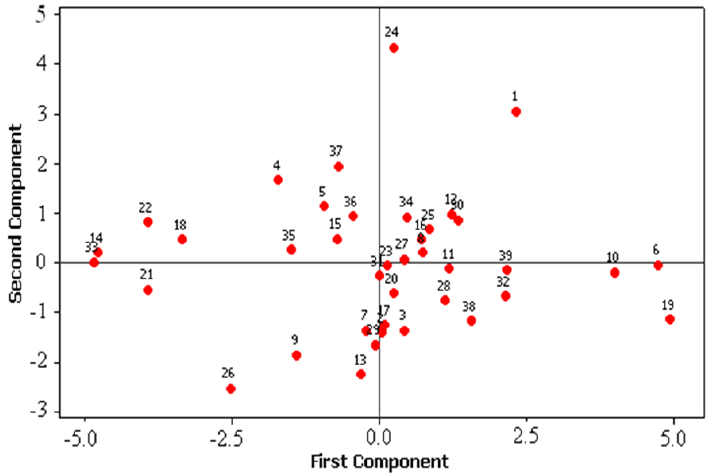
Fig. 4. Cultivars distribution biplot based on two first component for 1/3 continuous irrigation 1-‘Shiroodi’; 2-‘Aria’; 3-‘Darya’; 4-‘10’; 5-‘Kiknejad’; 6-‘Atila4’; 7-‘Akbari’; 8-‘Gods’; 9-‘Sepehan’; 10-‘Atila50’; 11-‘Sistan’; 12-‘Moghan1’; 13-‘Karaj3’;